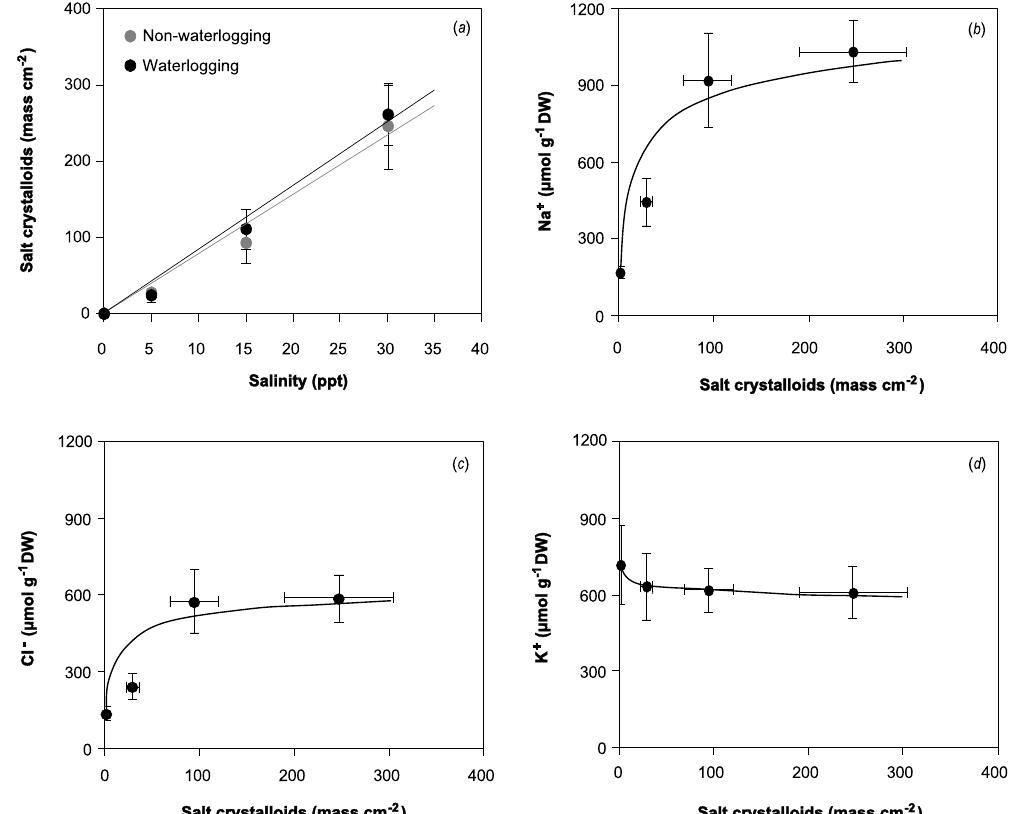
Figure 7. Amount of salt crystalloids secreted on S. alterniflora leaf surfaces subjected to the salinity gradient ( a ), and the relationships between salt secretion (on average waterlogging treatments) and Na + concentration ( b ), Cl − concentration ( c ) and K + concentration ( d ) in the